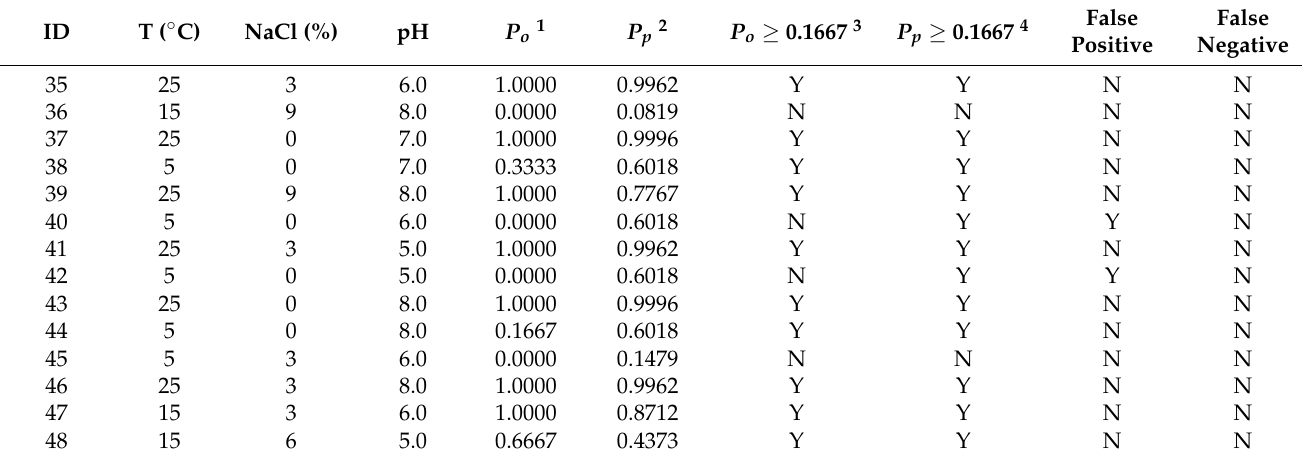
Table 3. Validation of logistic regression model and classification of adhesion and no-adhesion according to threshold (0.1667).